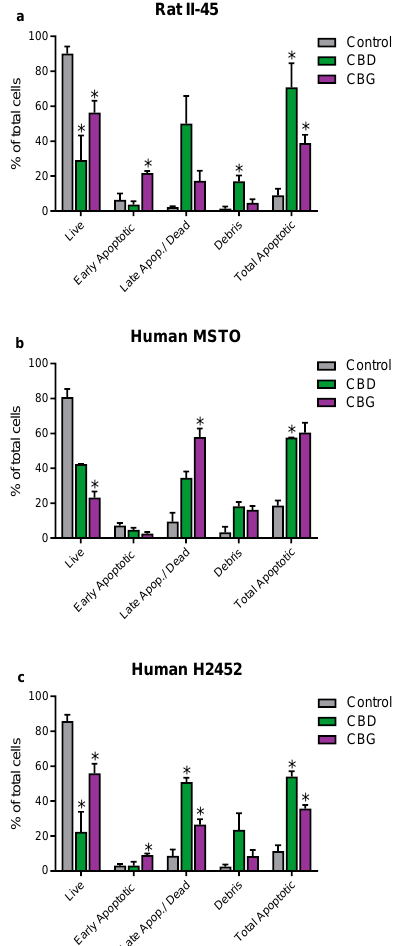
Figure 2. The phytocannabinoids cannabidiol (CBD) and cannabigerol (CBG) induce cell cycle arrest in mesothelioma cell lines. The effects of CBD and CBG (2xIC50) on cell cycle were assessed in rat II-45 ( a , b ), human MSTO ( c , d ) and H2452 ( e , f ) mesothelioma cell lines. After 24 h of treatment with vehicle (control), CBD or CBG, cells were harvested, and assays performed. Bars show the mean and SD from three independent experiments. p -values were calculated using two-way ANOVA Holm-Sidak’s multiple comparisons. ** p < 0.01, *** p < 0.001, and **** p < 0.0001 relative to vehicle-treated control cells.